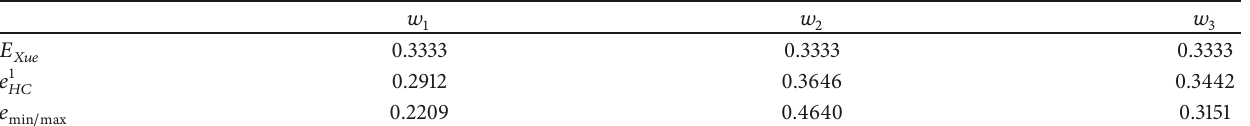
Table 7: Weight of